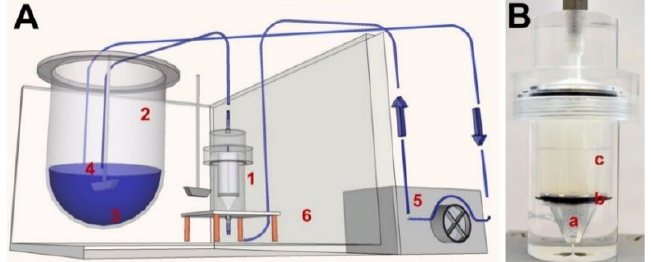
Figure 11. Schematic overview of the in vitro test setup ( A ) and photograph of the vFTC equipped with a 2 wt% agarose gel ( B ); (1) vFTC, (2) media container, (3) PBS of pH 7.4, (4) paddle stirred at 50 rpm, (5) peristaltic pump, (6) heated water bath, (a) glass beads, (b) stainless steel disc, (c) hydrogel, reproduced with permission from [59].